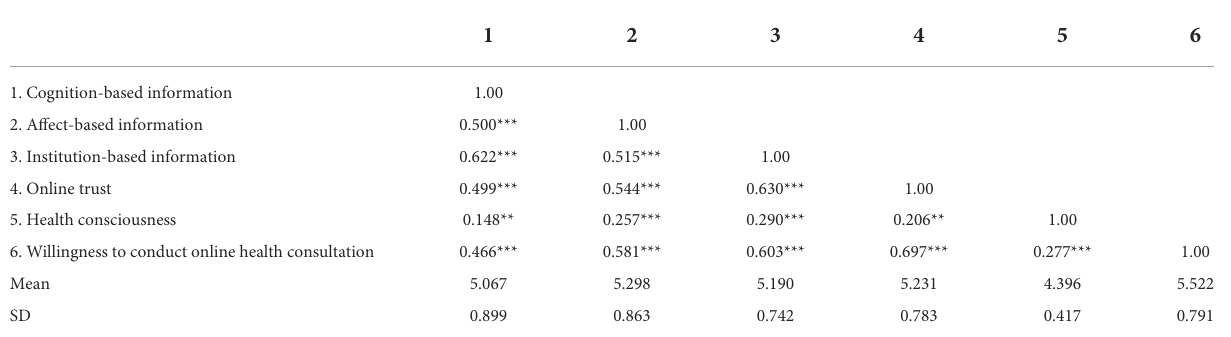
TABLE 2 Correlation matrix for all study